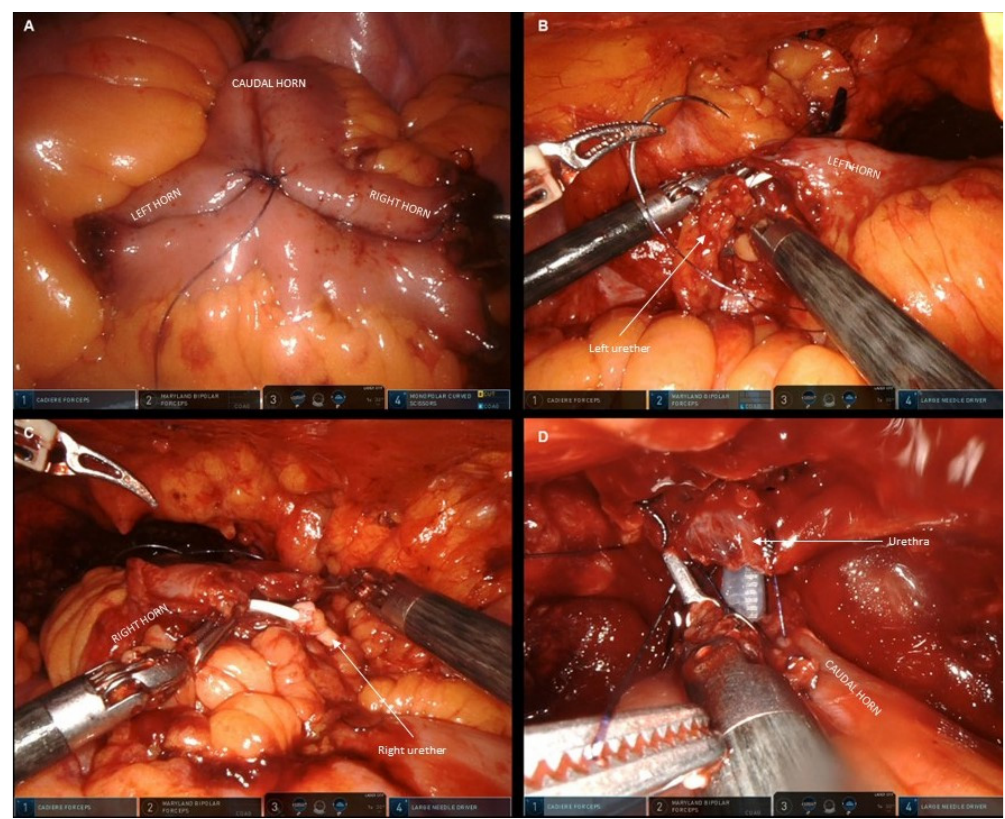
Figure 3. ( A ) Final shape of the neobladder prior to the ureteral and urethral anastomosis. ( B ) Anas- tomosis of the right ureter in the right horn. ( C ) Anastomosis of the left ureter in the left horn. ( D ) Anastomosis of the caudal horn to the urethra.